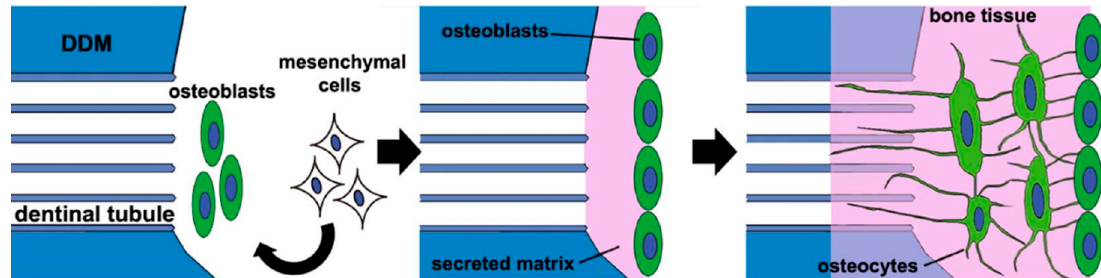
Figure 3. A schematic of the new bone formation process after human demineralized dentin matrix (DDM) transplantation in rat skeletal defects [19]. When the human DDM is transplanted into the rat calvarial defect, a small amount of bone morphogenic proteins (BMPs) that are gradually released from the DDM induce mesenchymal cells to differentiate into osteoblasts. The osteoblasts secrete the matrix and form a new osteoid with embedded osteocytes, which are buried osteoblasts. The osteocytes then form a network on the DDM surface, with some of them extending into the dentinal tubules.